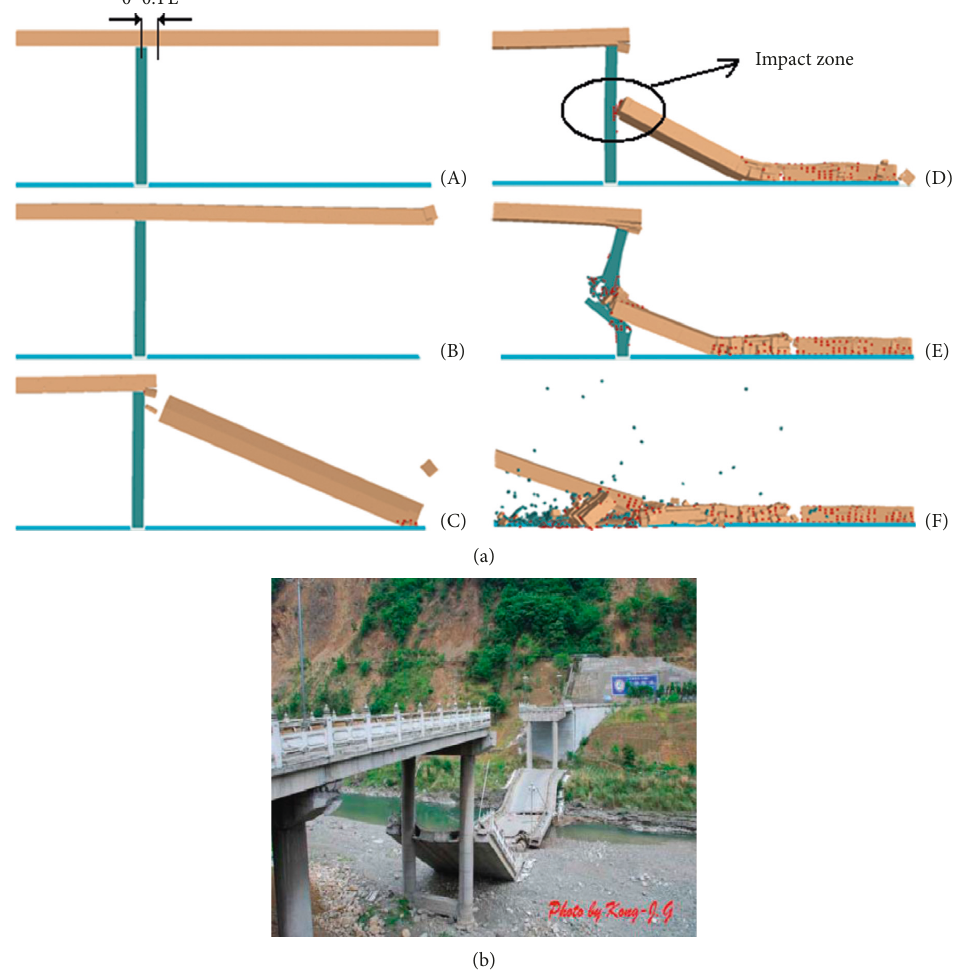
Figure 13: First types of progressive collapse of bridges (domino-type progressive collapse) (a) in analysis: (A) stable condition, (B) initial crack in abutment support, (C) falling down of the first span deck on the ground, (D) collision of the other side of the deck with pier, (E) shear fracture of pier and instability of second span, and (F) complete collapse of first span; (b) in practice.